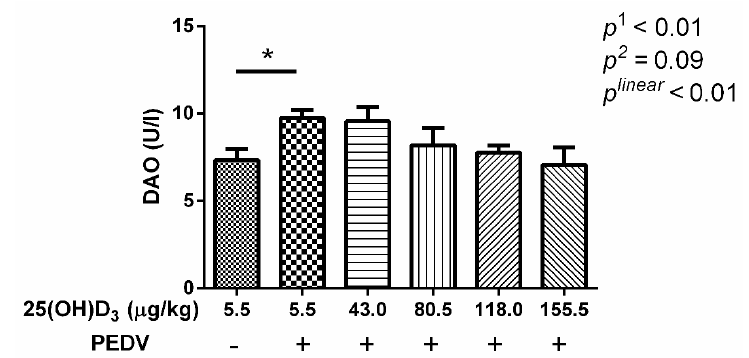
Figure 1. Serum diamine oxidase activity (DAO) activity of weaned piglets fed 25(OH)D3 as indicated with PEDV challenge. The p 1 means t -test between CON and CON-PEDV, and p 2 value means multiple comparisons among the PEDV challenge groups.